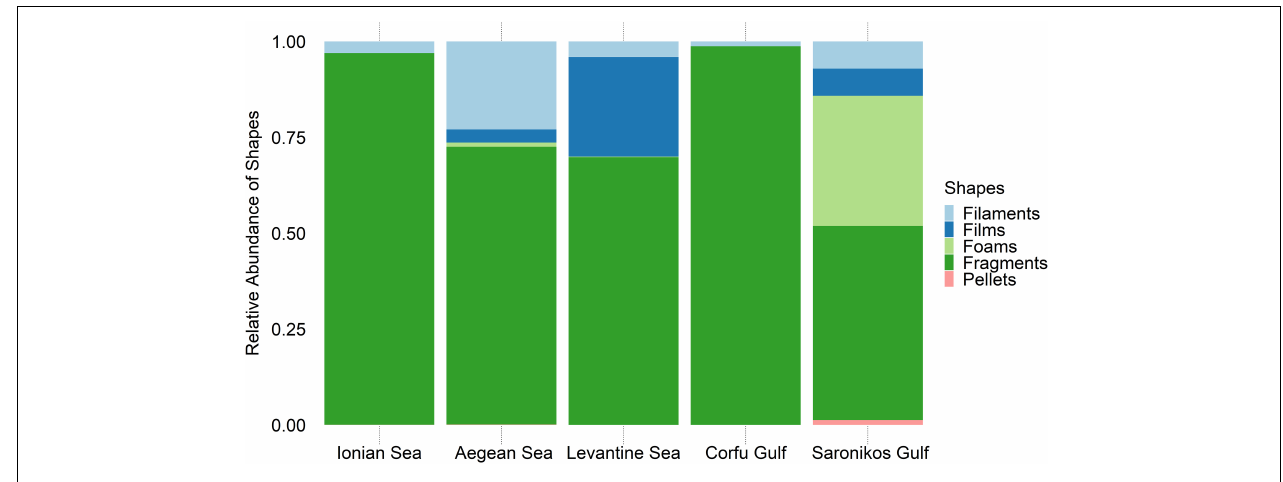
FIGURE 4 | Relative abundance of MPs shape types at the studied